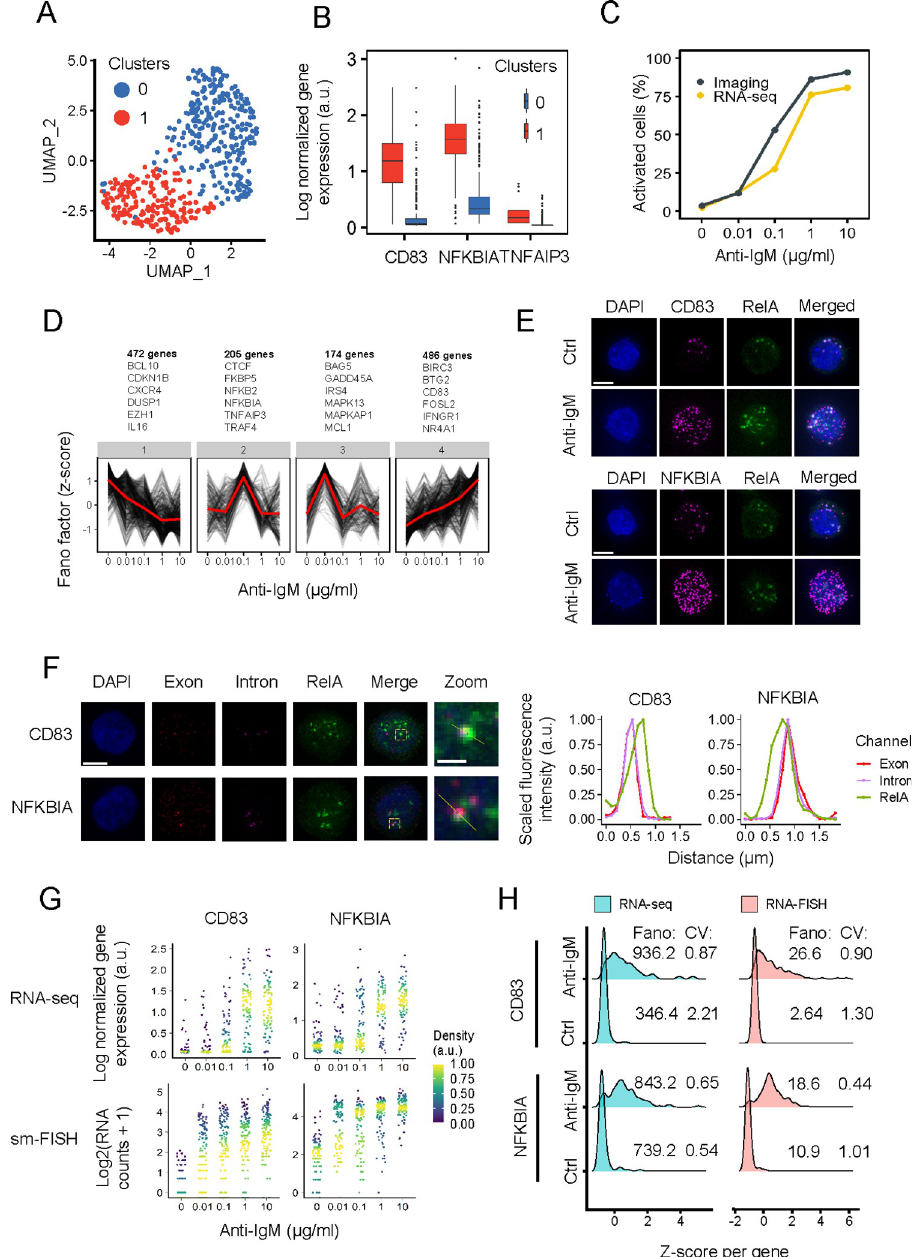
Fig 2. NF- κ B SE-regulated genes demonstrate SE-like dynamics. (A) UMAP projection of the dimensionality reduction and clustering results of 453 cells scRNA-seq stimulated with various anti-IgM doses. (B) Box plot of the expression of known marker genes used to identify activated (red) and inactivated (blue) cell clusters. (C) Cell activation ratio from imaging obtained using logistic regression of foci at 20 min compared with the cell activation ratio from RNA-seq. (D) Hierarchical clustering analysis of Fano factors across anti-IgM concentrations for marker genes. The red lines represent the means. (E) Micrograph of CD83 and NFKBIA smRNA-FISH (scale bar, 5 μ m). (F) Micrograph of CD83 and NFKBIA intronic smRNA-FISH (scale bar, 5 μ m; zoomed scale bar, 1 μ m). (G) RNA expression of CD83 (B cell activation marker) and NFKBIA (NF- κ B target gene) across dose points obtained from scRNA-seq (upper graph) and smRNA-FISH (lower graph). (H) Density plot of CD83 and NFKBIA single-cell expression obtained from scRNA-seq and smRNA-FISH after stimulation with or without 10 μ g/mL anti-IgM.